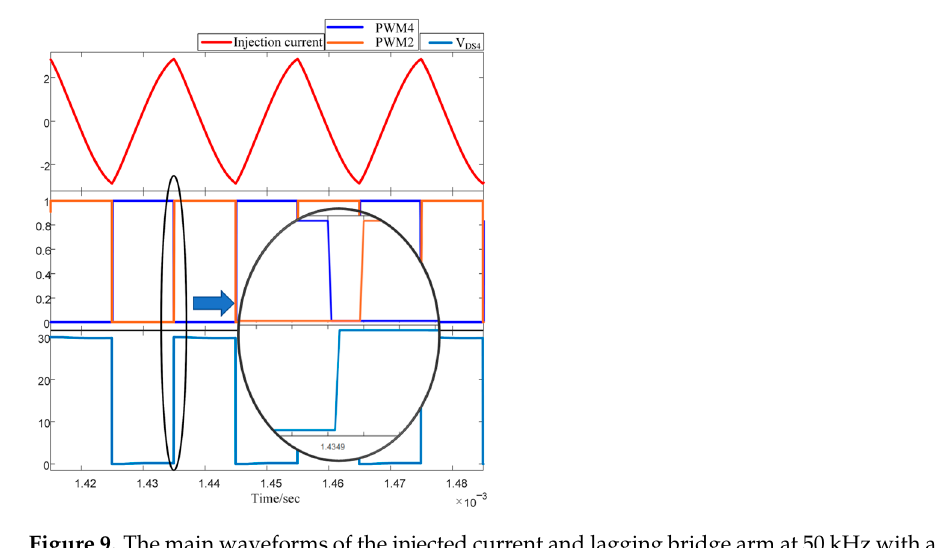
Figure 9. The main waveforms of the injected current and lagging bridge arm at 50 kHz with auxiliary current source.